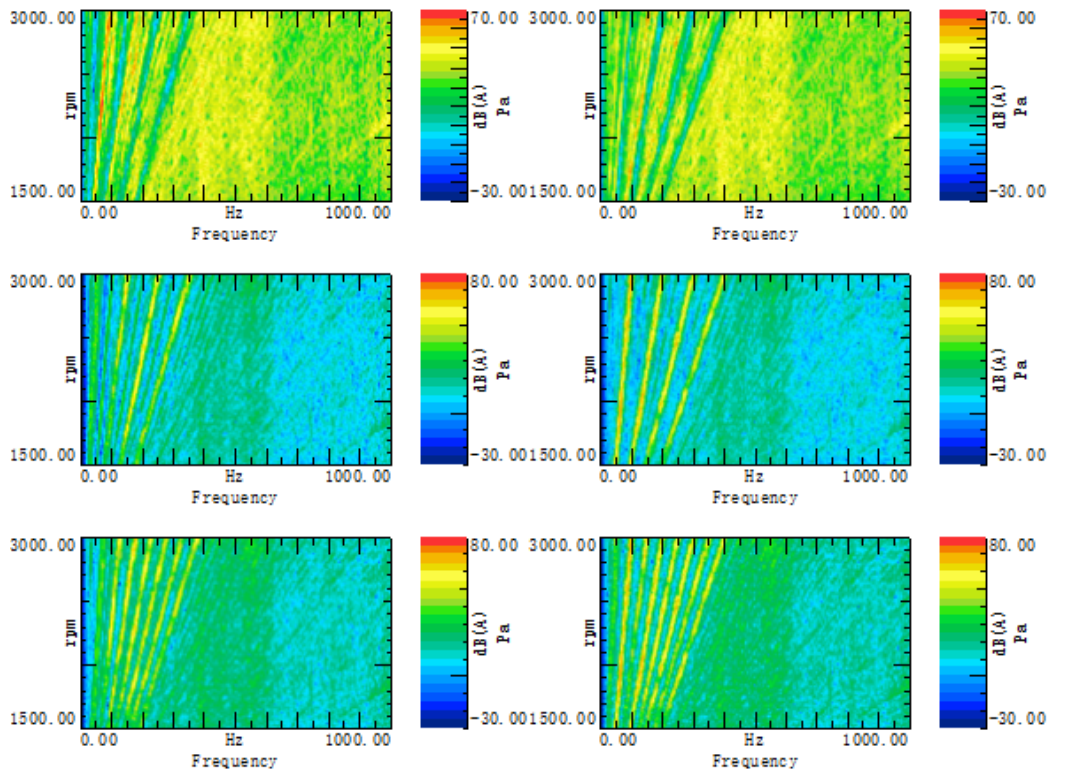
Figure 10. Spectrum of sound samples after order adjustment.